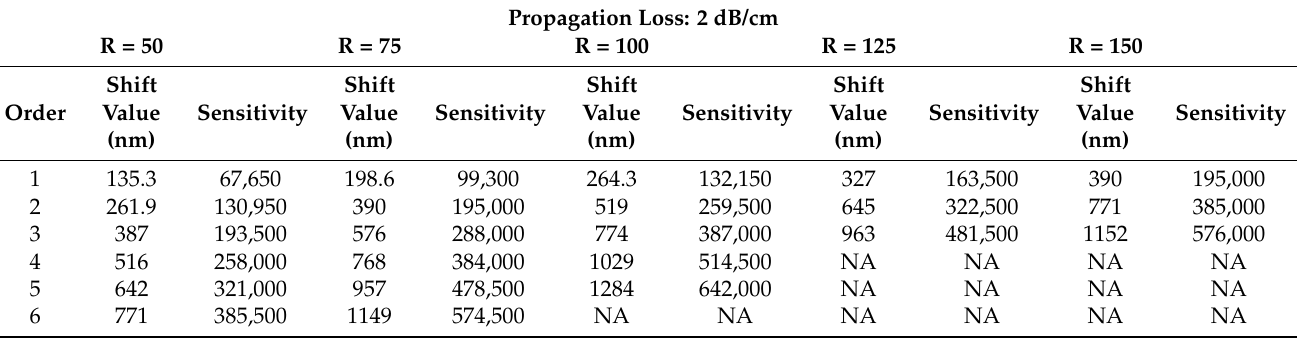
Table 2. The order shift distance and sensitivity for five different MRR radii under two cladding-layer refractive indices—1.31 and 1.312 for 2 dB/cm propagation loss. (R represents the